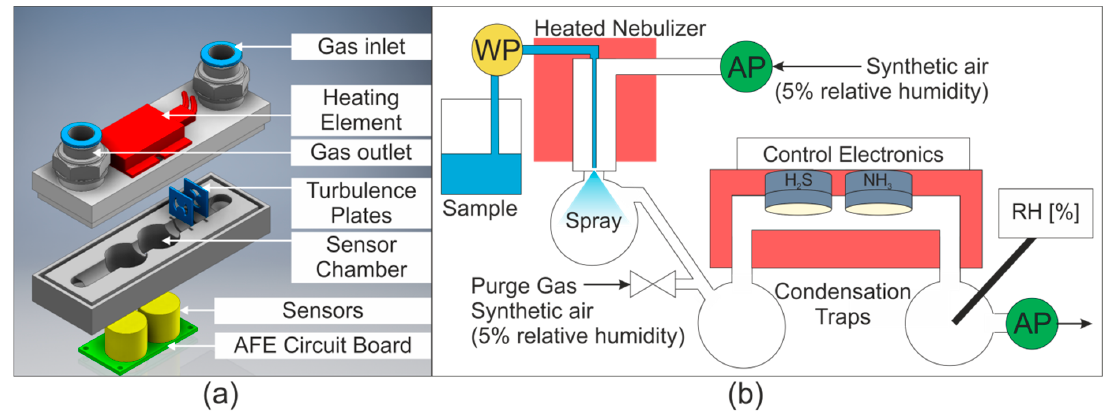
Figure 1. ( a ) Sensor chamber. AFE = Analog Front End. ( b ) Gas and water flow in system. WP = water pump, AP = air pump, RH = relative humidity sensor. Temperature controlled areas are shaded in red. The purge gas valve was opened to dry the sensors between measurements.